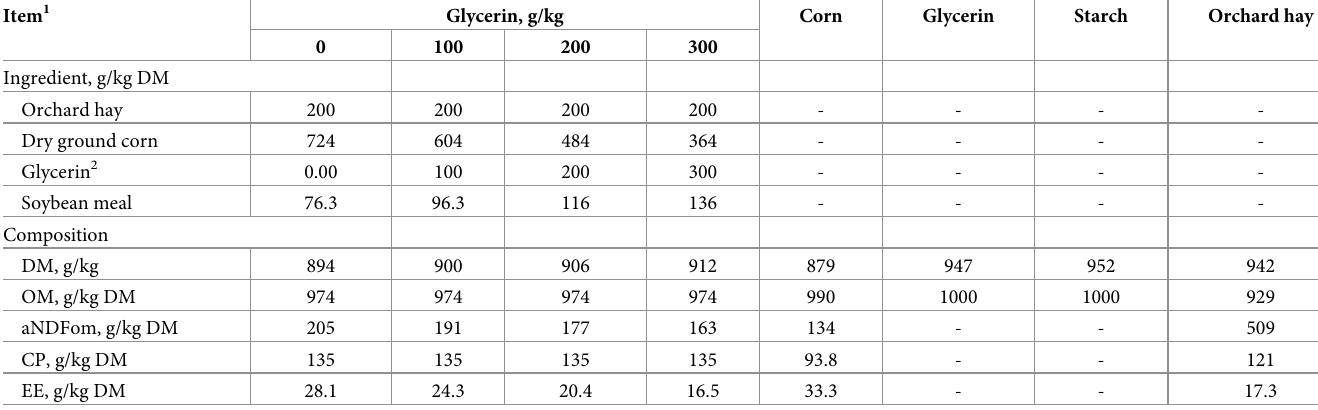
Table 1. Ingredients and chemical composition of experimental diets and feeds.